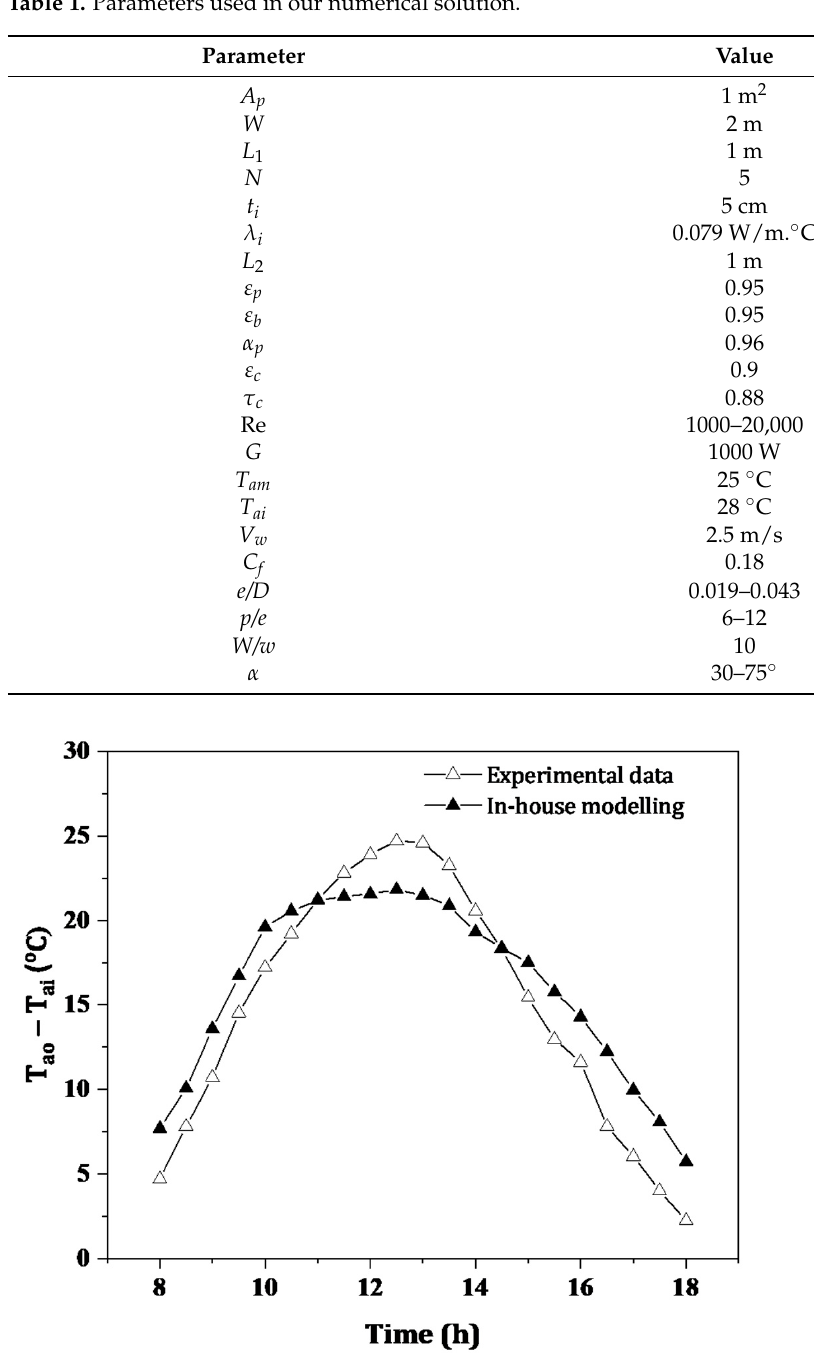
Figure 4. TTPP versus Re based on our in-house predictions and experimental data inferred from [16]. 3. Results The useful energy, η th , and η t-th of SAH roughened by V-down ribs, which were cal- culated based on the numerical solution for numerous flow and roughness characteristics, are discussed below. To examine the improvement in useful energy, η th , and η t-th due to artificial roughness parameters, the findings were compared with those of smooth ducts operating under the same conditions. The effect of Re on the useful energy with various values of p/e and fixed values of α = 55°, e/D = 0.031, and W/w = 10 is depicted in Figure 5a. Clearly, useful energy rapidly increased when Re increased. It meant that as Re rose, the convective heat transfer coeffi- cient rose as well. This might have been due to the flow slowing down, creating an unfa- vourable pressure gradient that increased instability, eddy formation, and flow separation